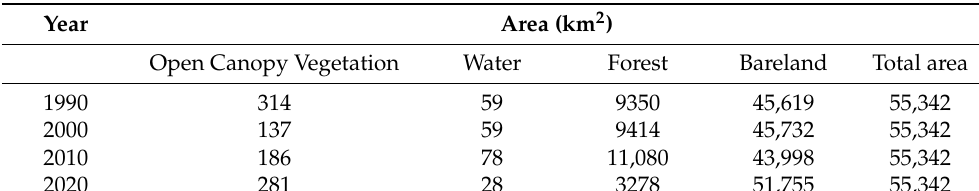
Table 4. Land-use types in the High Atlas Mountains of Morocco classified from Landsat imagery using the SVM method.